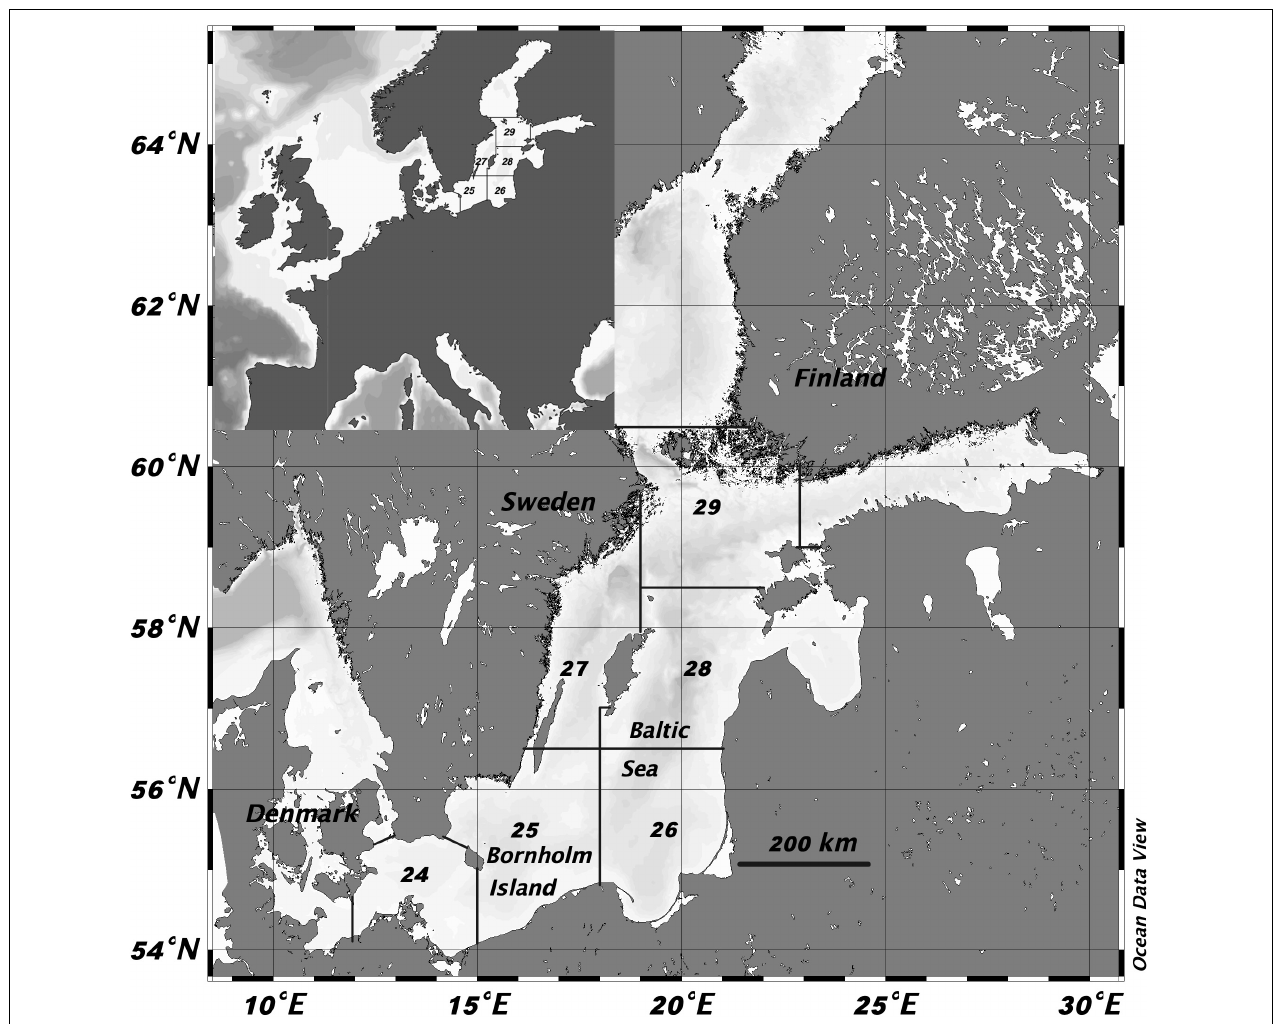
FIGURE 1 | The Baltic Sea is shown with the borders and numbers of the ICES subdivisions (SD) (www.ices.dk). The Baltic cod reproduction takes place around of the Bornholm island. A map over Europe is inserted for orientation purposes.